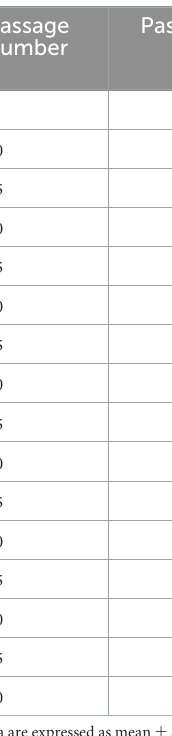
TABLE 1 Immortalized OFTu cell line